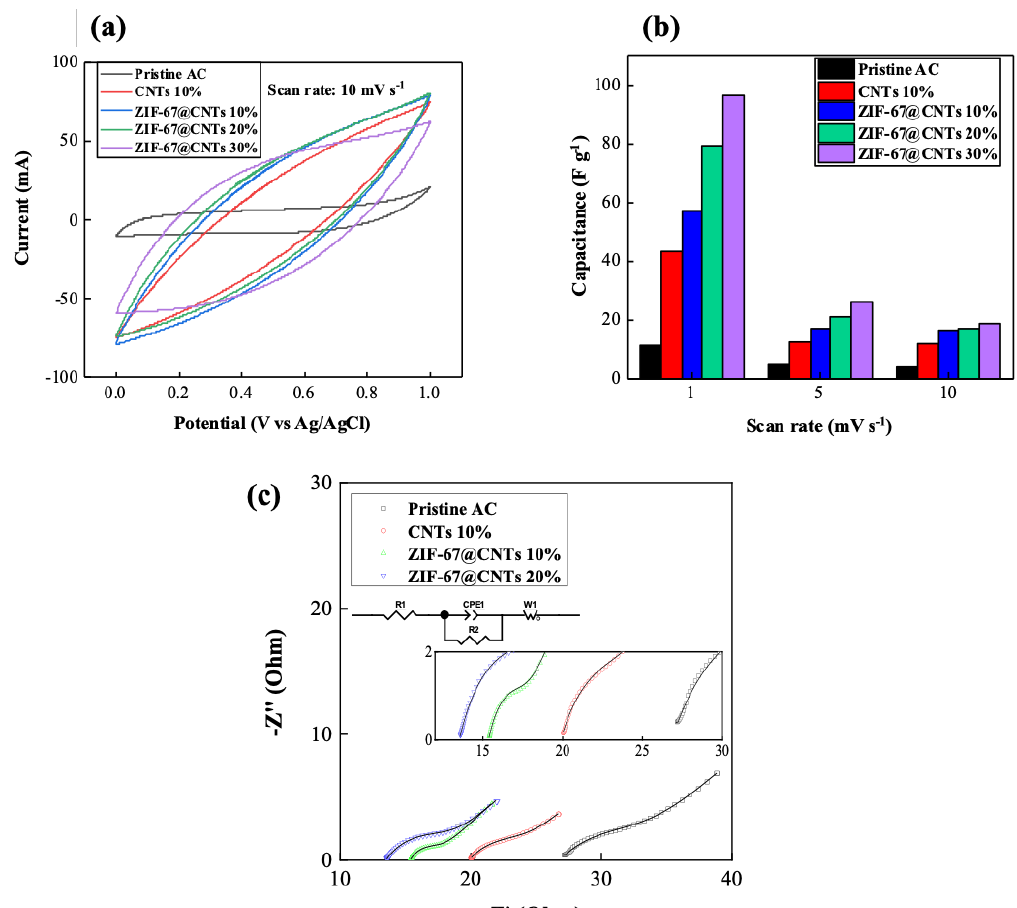
Figure 7. ( a ) Cyclic voltammetry (CV) curves measured for CDI cells at a scan rate of 10 mV / s. ( b ) Change in capacitance calculated from CV measurements at various scan rates. ( c ) Electrochemical impedance spectroscopy (EIS) data (symbols) measured under CDI operation mode with various electrodes and fitting result (line) using corresponding equivalent circuit.